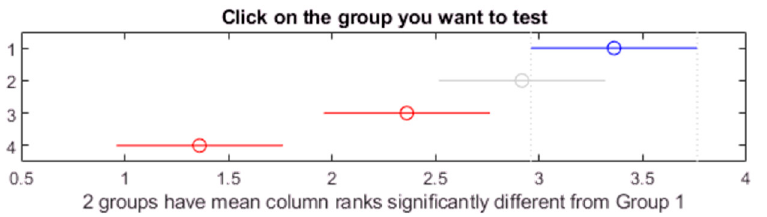
Figure 22. Post hoc Bonferroni test for oil Midel 1204 with different concentrations of surfactant ROKwinol80 .